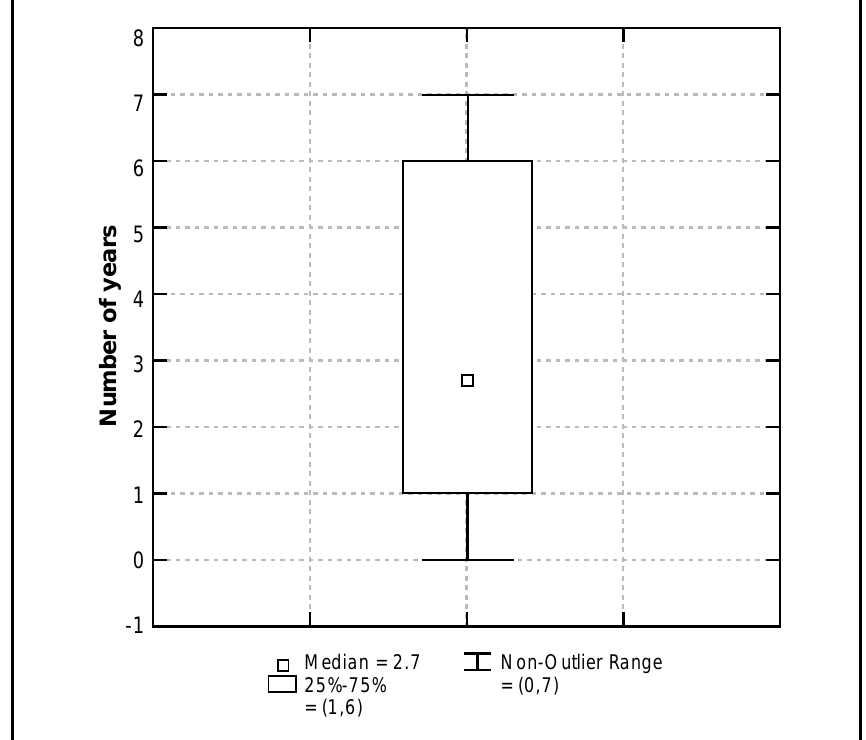
Figure 2: Number of years participants were involved in student supervision